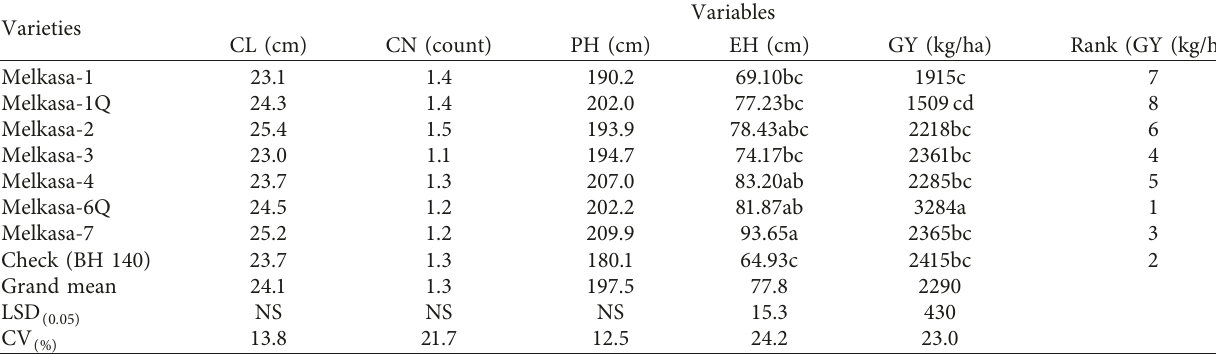
Table 3: Combined mean values of agronomic traits for maize varieties at Salayish and Angila-4 locations during 2017 and 2018 in Basketo special and Melokoza districts, Southern Ethiopia.